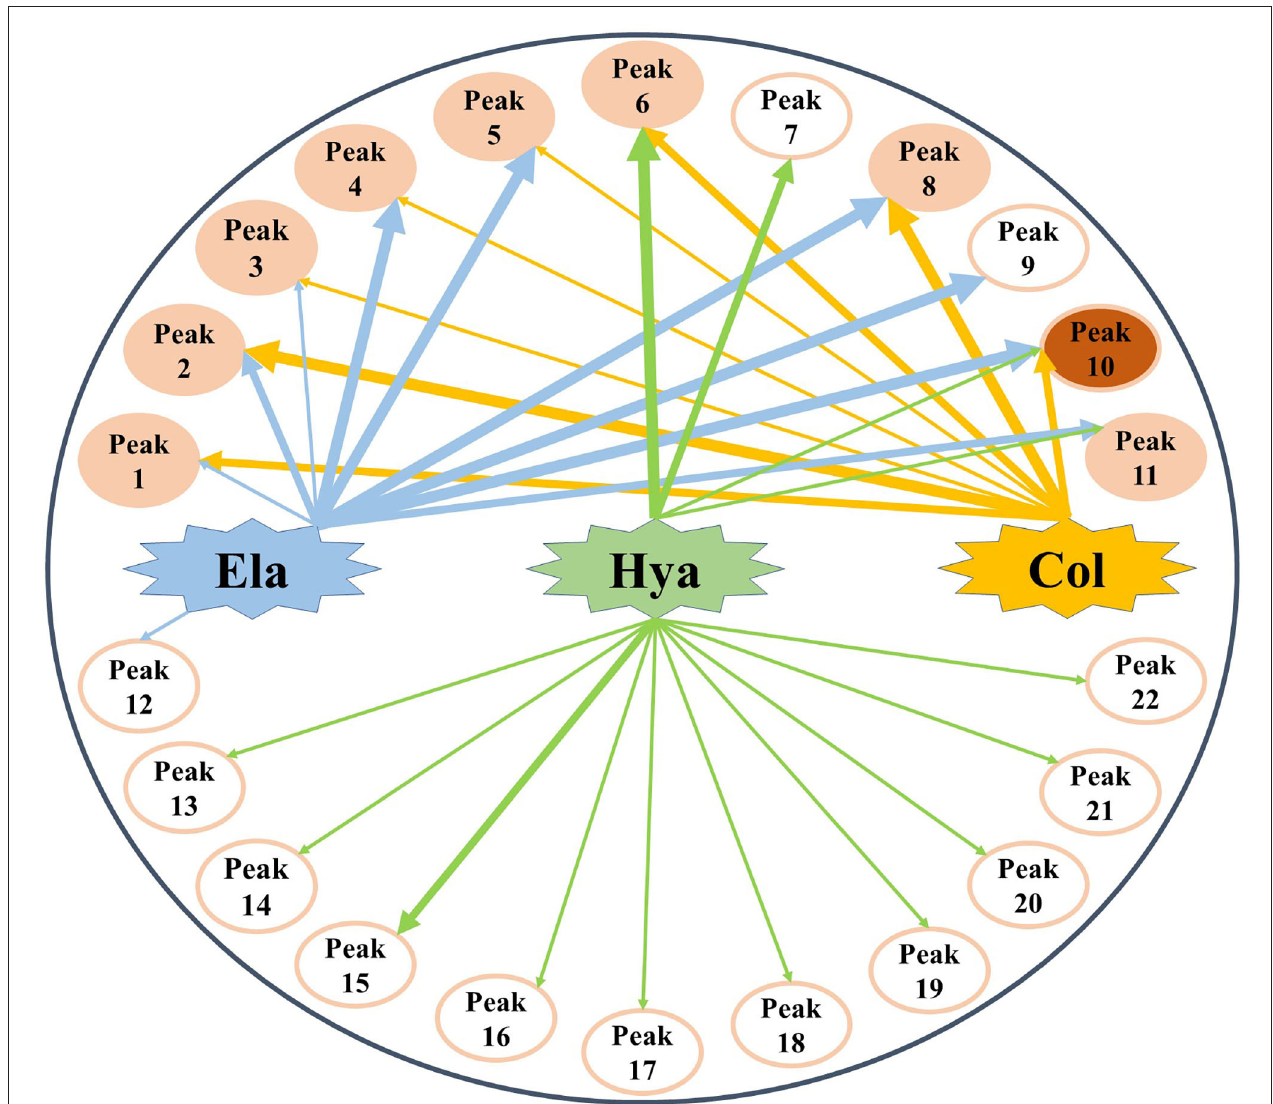
FIGURE 5 | The multicomponent and multi-target network between target enzymes and their corresponding potential bioactive ligands screened out from M. oleifera leaf extracts. The thicknesses of lines roughly represent the binding intensity for their corresponding interactions. Ela, elastase; Hya, hyaluronidase; Col,